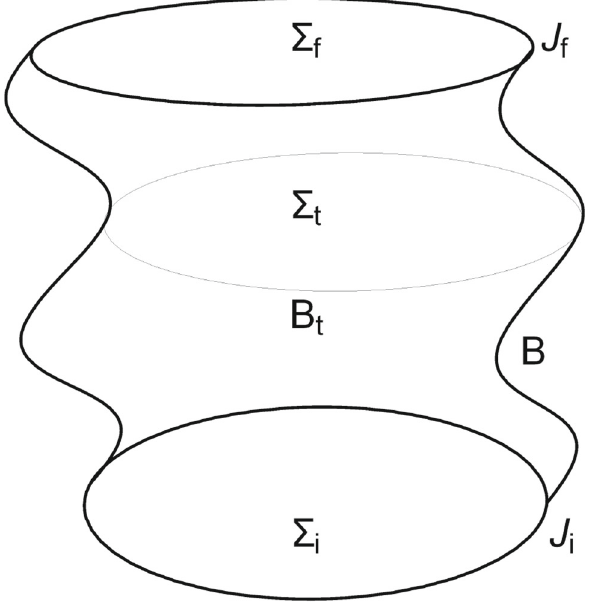
Fig. 1 The spacetime manifold M, the spacelike boundaries (cid:2) i , and (cid:2) f , the timelike boundary B, and the junctions J i , and J f